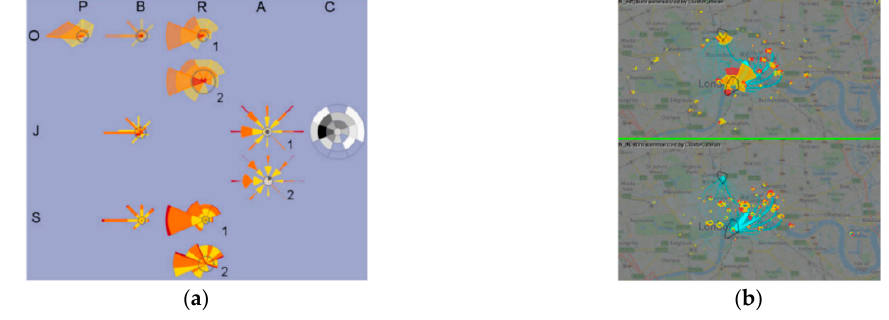
Figure 51. Difference diagram visualization [132]: ( a ) column labels represent shapes, and line labels represent methods for combining components; and ( b ) OD-flow subsets with incoming and outgoing locations displayed by flow lines.